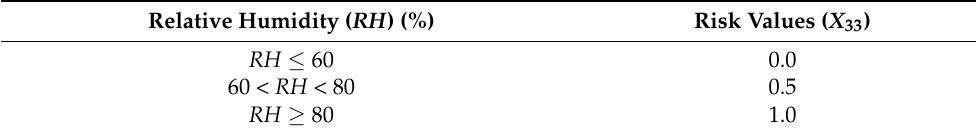
Table 2. Relation between relative humidity and risk value.